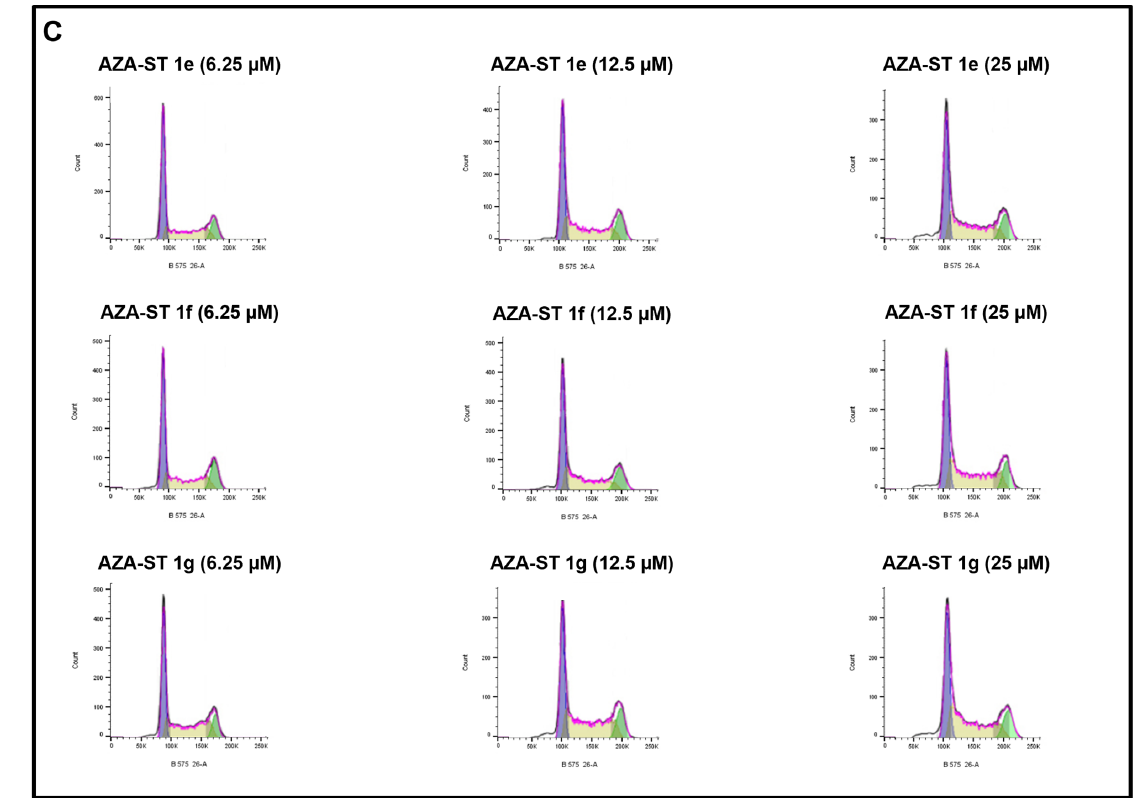
Figure 9. Flow cytometric analysis of the distribution of the cells in the different phases of the cell cycle: effects of AZA-ST 1a–g and resveratrol. N2a cells were incubated for 24 h with or without AZA-ST 1a–g or resveratrol (RSV; trans -resveratrol) at concentrations inclosing the IC50s (6.25, 12.5 and 25 µM). ( A ): Control, vehicles (DMSO and EtOH); ( B ): AZA-ST 1a–d; ( C ): AZA-ST-1e–g. Vehicles (Ethanol (EtOH) for RSV; DMSO for AZA-ST) [15]: Ethanol (EtOH; 0.05%) and DMSO (0.05%); only the highest concentrations of vehicles were analyzed. White: SubG1; purple: G0/G1 phase; yellow: S phase; green: (G2 + M) phase.